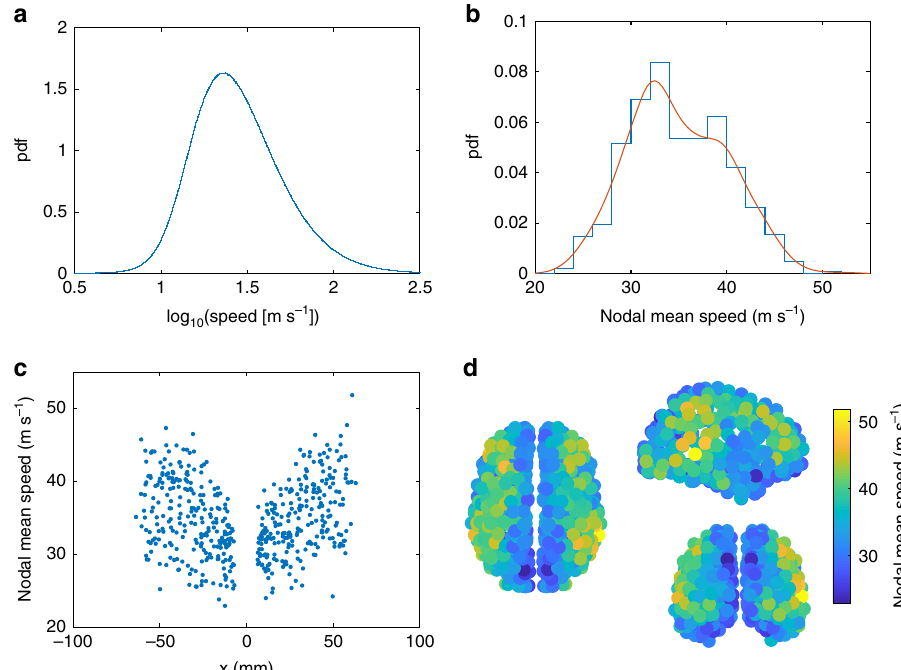
Fig. 2 Wave propagation speeds. a Histogram of log 10 (speed) across all nodes and times. b Histogram of average speed (in m s − 1 ) at each node. Red line shows a kernel density estimate. c Mean speed in each region as a function of the lateral distance from the midline ( x = 0). d Spatial distribution of nodal mean speeds as viewed (clockwise from left) from the top, right, and back. These results are for strong coupling c = 0.6 and short delay τ = 1 ms, as in Fig. 1. Source data are provided as a Source Data fi